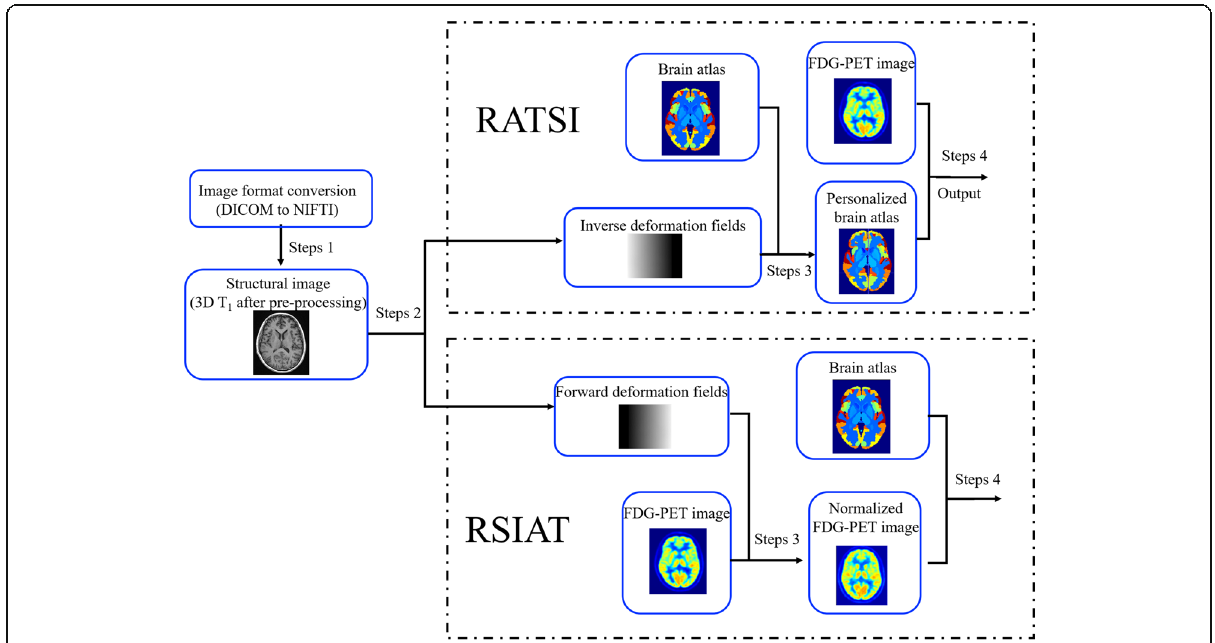
Fig. 2 The diagram displaying the processing steps of the two atlas-based automatic methods for whole brain automatic segmentation and regional 18 F-FDG PET